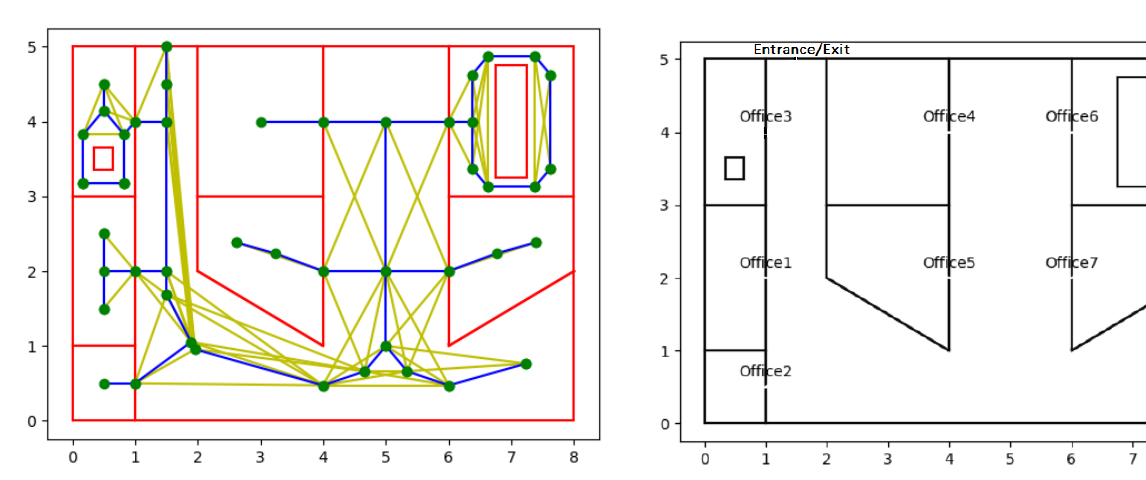
Figure 2. Association between nodes and text names to identify office doors and main